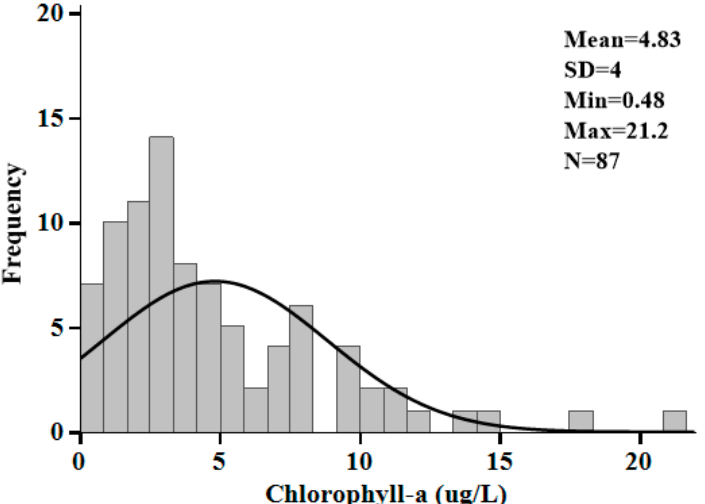
Figure 3. Distribution of chl- a concentrations in the WBLE during June–July 2012.